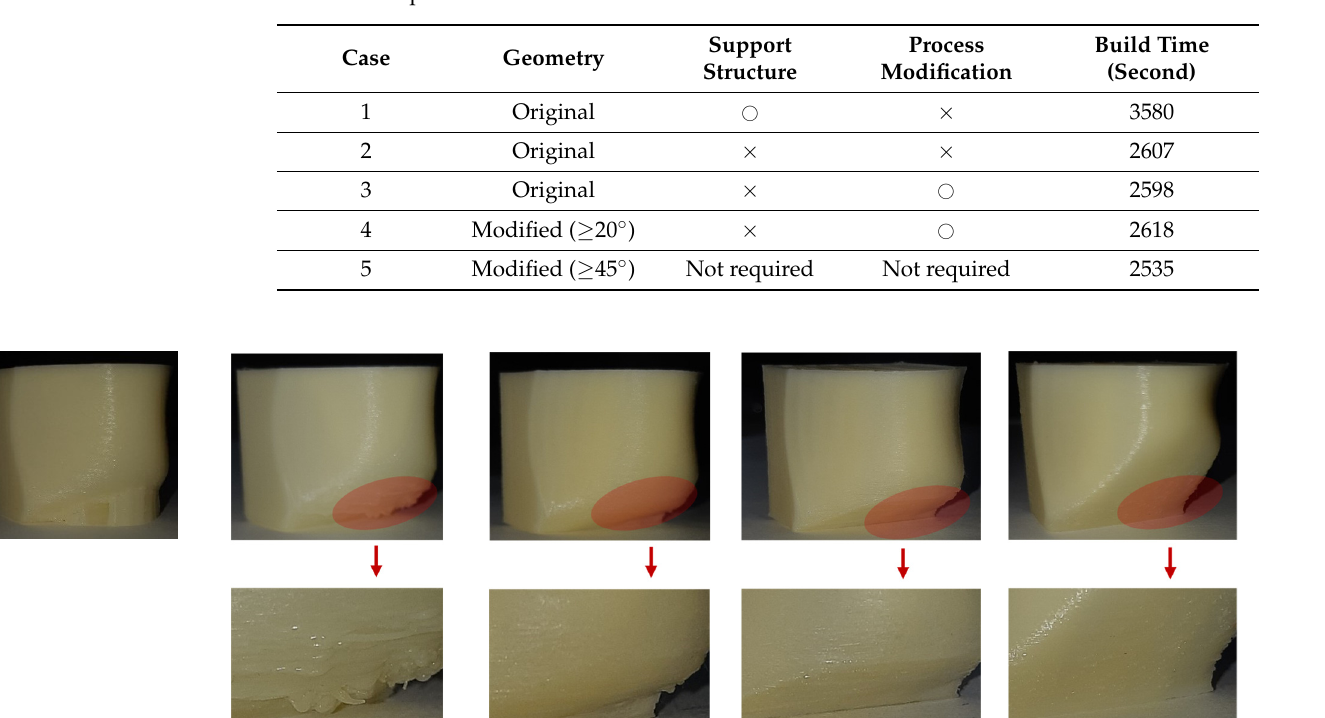
Table 7. Comparison of fabrication cases.